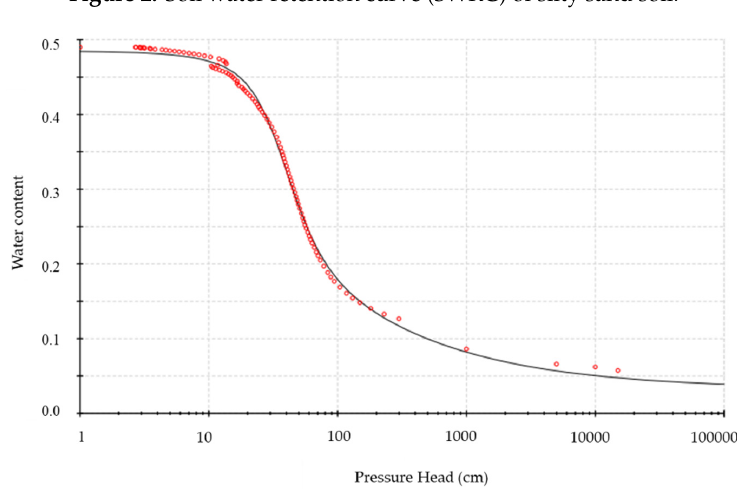
Figure 3. Soil water retention curve (SWRC) of oxisol.